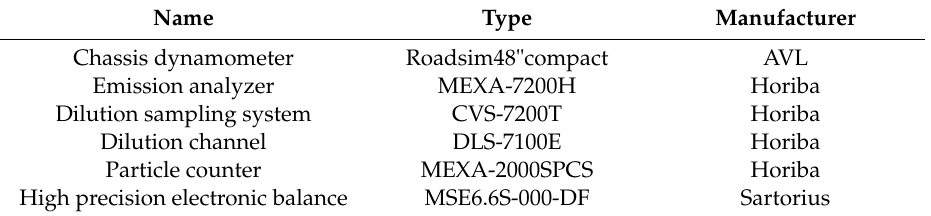
Table 2. Major equipment. 191